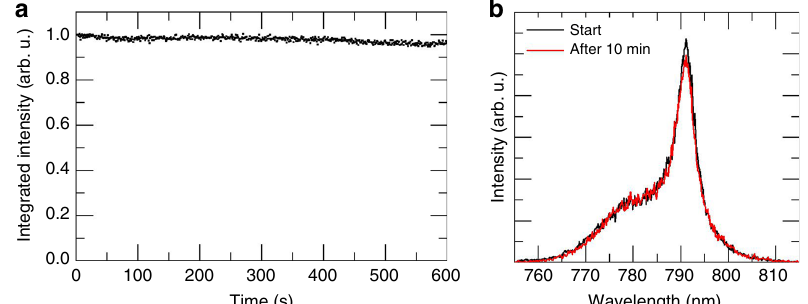
Fig. 4 ASE stability at CW excitation with an excitation intensity of 720 W cm − 2 at 80 K. a Integrated emission intensity over a time frame of 10 min of continuous excitation. b Spectra at the beginning of the measurement (black) and after 10 min